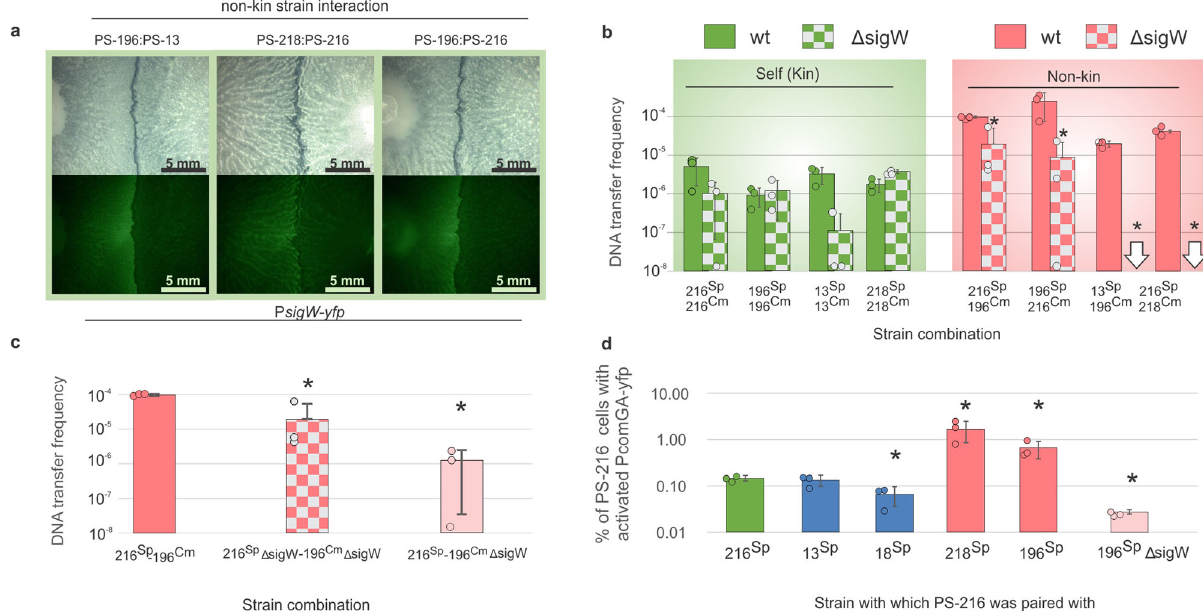
Fig. 5 Cell envelope stress and competence induction in swarm boundaries. a Meeting points of non-kin sigW - yfp swarms. b The effect of stress response inactivation ( Δ sigW ) on transformation rate. Green depicts control self-combinations and red depicts non-kin combinations; full columns and chequered columns represent wt controls and Δ sigW mutants respectively. Asterisks represent statistically signi fi cant values (two tailed Student ’ s t- test for unpaired data assuming equal variances, p 216-196 = 0.01, p 196-216 = 0.05). c The effect of sigW inactivation in a non-kin donor strain on transformation frequency in recipient strain PS-216. Red column = PS-216 and PS-196 wt control donor, chequered column = PS-216 Δ sigW and PS-196 Δ sigW donor, pink column = PS-216 and PS-196 Δ sigW donor. Asterisks represent statistically signi fi cant values (two tailed Student ’ s t -test for unpaired data assuming equal variances, p WT-216 Δ sigW:196 Δ sigW = 0.01; p WT-216:196 Δ sigW = 0.00002). d Activation of competence genes in strain PS-216 comGA-yfp at the meeting point with self (PS-216 Sp )(green), kin strains (PS-13, PS-18) (blue) and non-kin strains (PS-196, PS-218 (red) and Δ sigW PS-196 (pink)). Bars represent fractions of PS-216 cells expressing the comGA gene at swarm meeting points. Data are presented as mean values± SD and error bars represent SD of the mean values. Assays were replicated three times. Asterisks represent statistically signi fi cant values (two tailed Student ’ s t- test for unpaired data assuming equal variances, p 216-18 = 0.02, p 216-218 = 0.03, p 216-196 = 0.03, p 216-196 Δ sigW = 0.0005, p 196-196 Δ sigW = 0.02, see Supplementary Notes). See Table 2 for strain abbreviations and for strain combinations see Supplementary Table